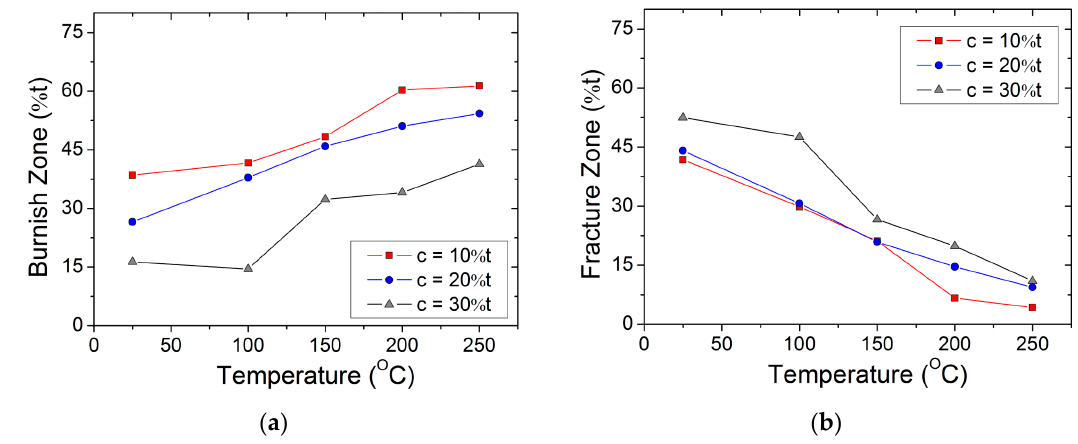
Figure 8. ( a ) Variation of the burnish zone (expressed as a percentage of the workpiece thickness) with temperature for various punch–die clearances; ( b ) variation of the fracture zone (expressed as a percentage of the workpiece thickness) with temperature for various punch–die clearances.